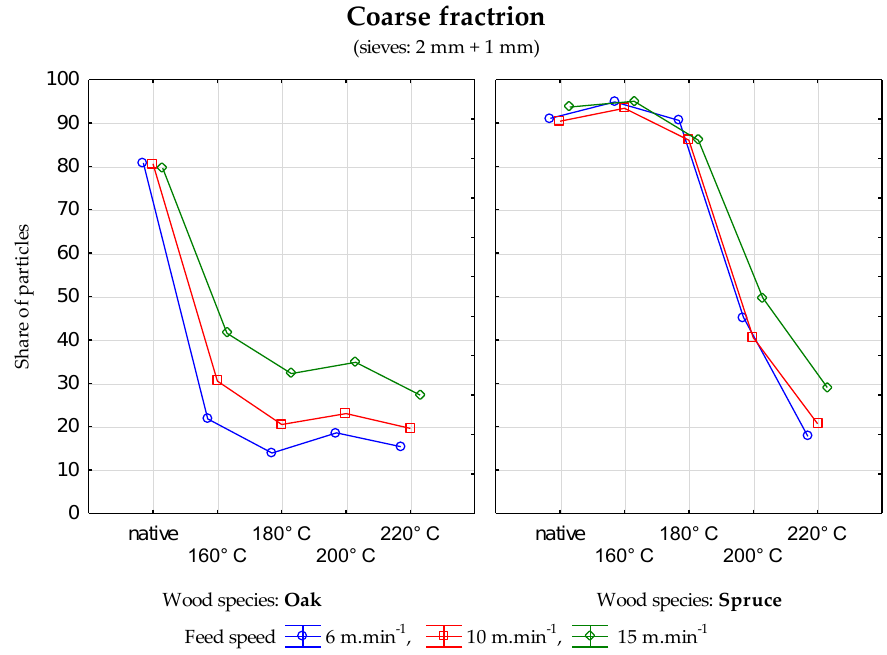
Figure 1. Percentage of particles in the mesh size of 2 mm and 1 mm—coarse fraction depending upon the temperature modification of oak and spruce.